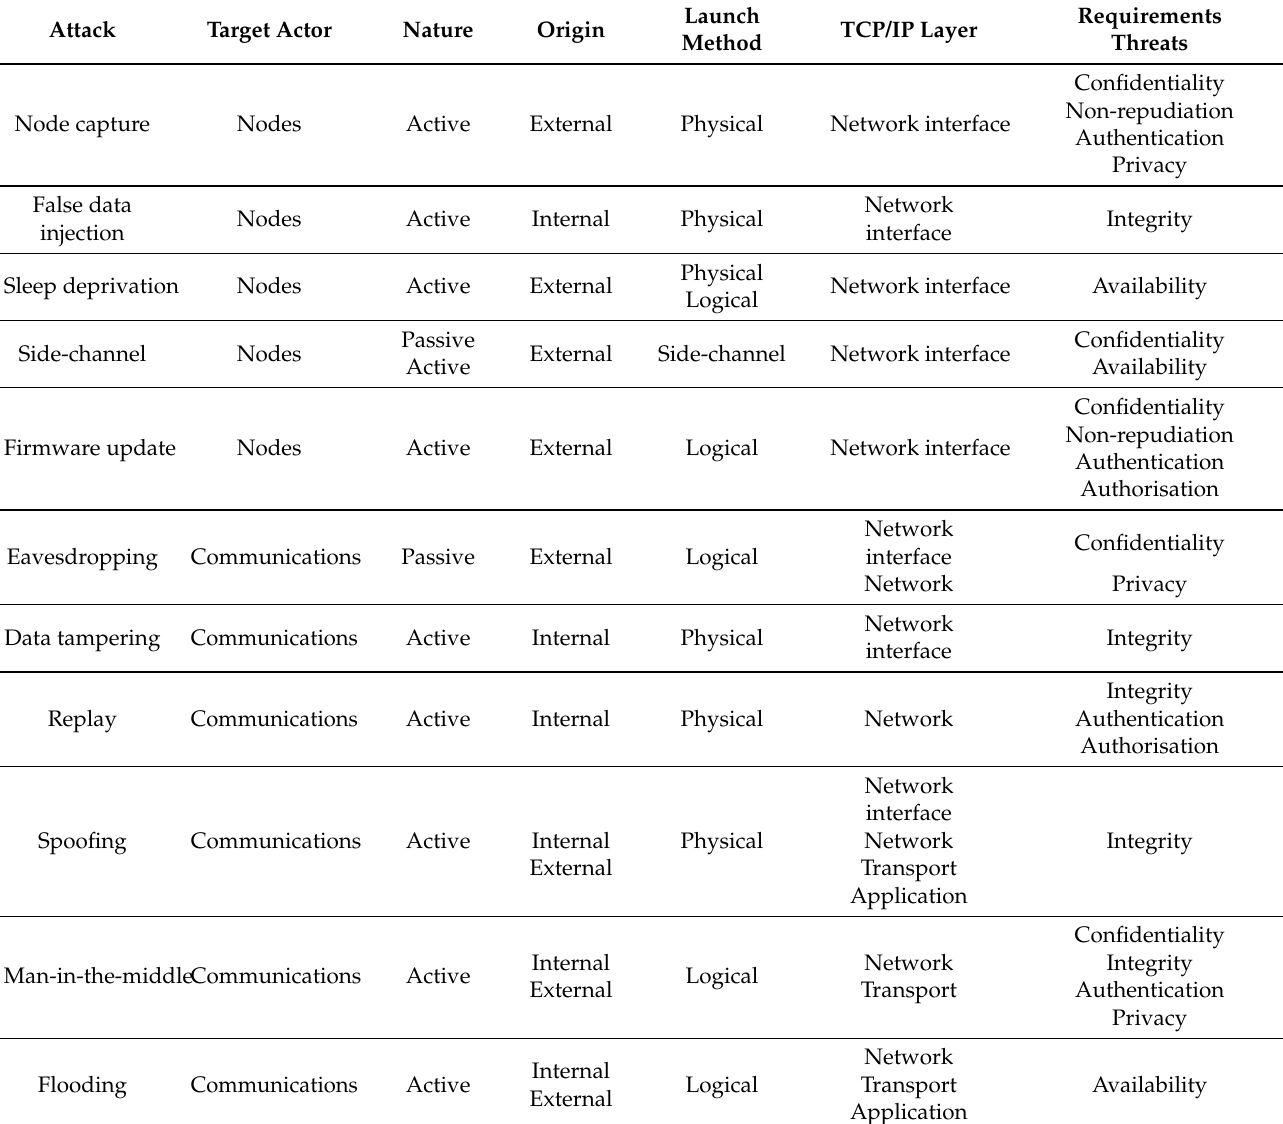
Table 13. Summary and classification of security attacks in smart healthcare